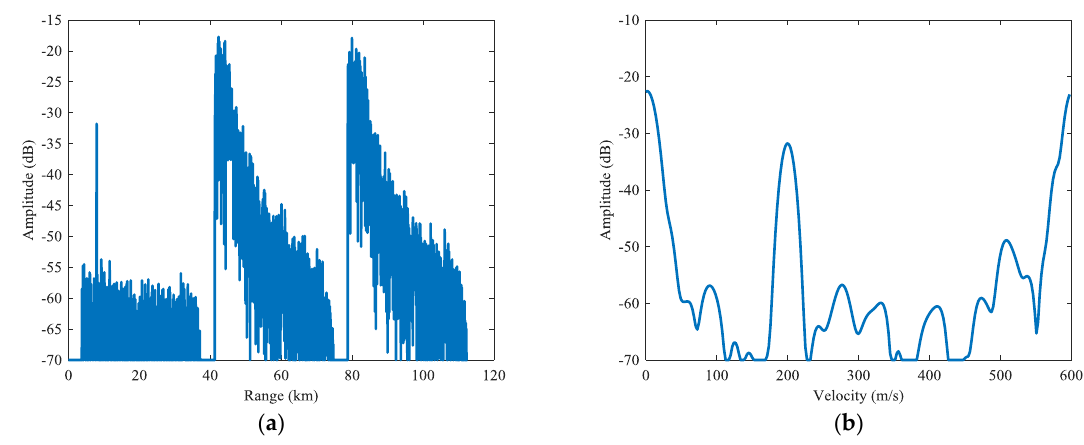
Figure 9. Cross profiles of Target 1 for the basic PD process: ( a ) range profile, ( b ) Doppler profile.